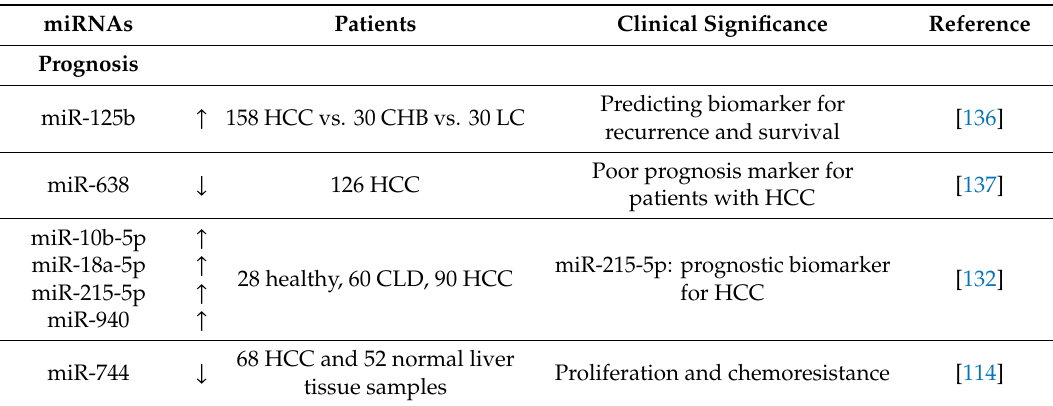
Table 3. miRNA use as biomarkers for prognosis of